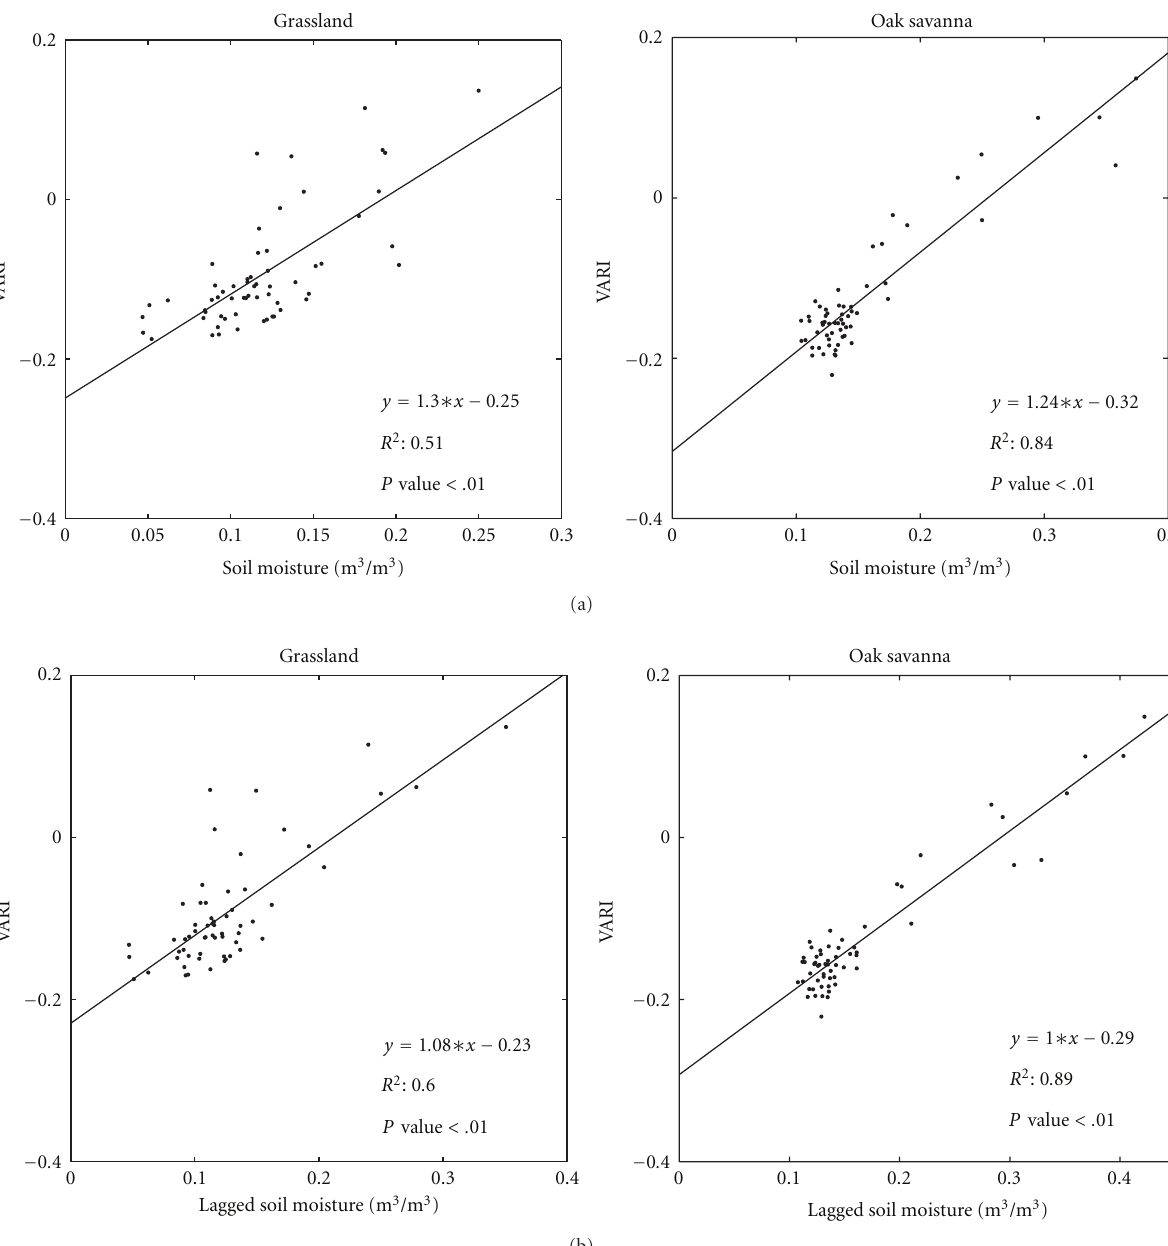
Figure 5: The relationships between VARI and averaged soil moisture (a), lagged soil moisture (b) at 10cm in the open grassland and at 20cm in the oak savanna during the dry-down and senescence